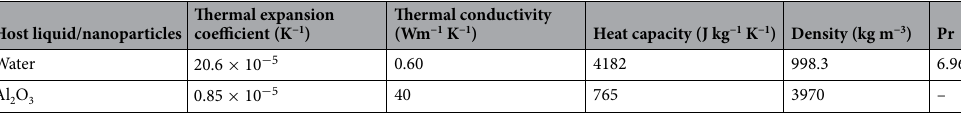
Table 1. Thermophysical values of the particles and hist